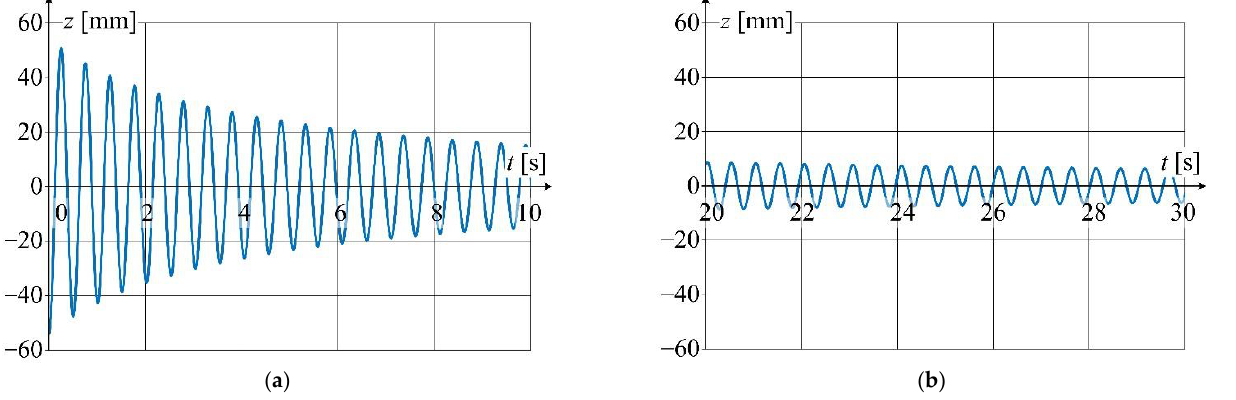
Figure 20. Detailed graphs of displacement waveform (Figure 19): ( a ) for the first 10 s of oscillation; ( b ) for 20 to 30 s of oscillation time.